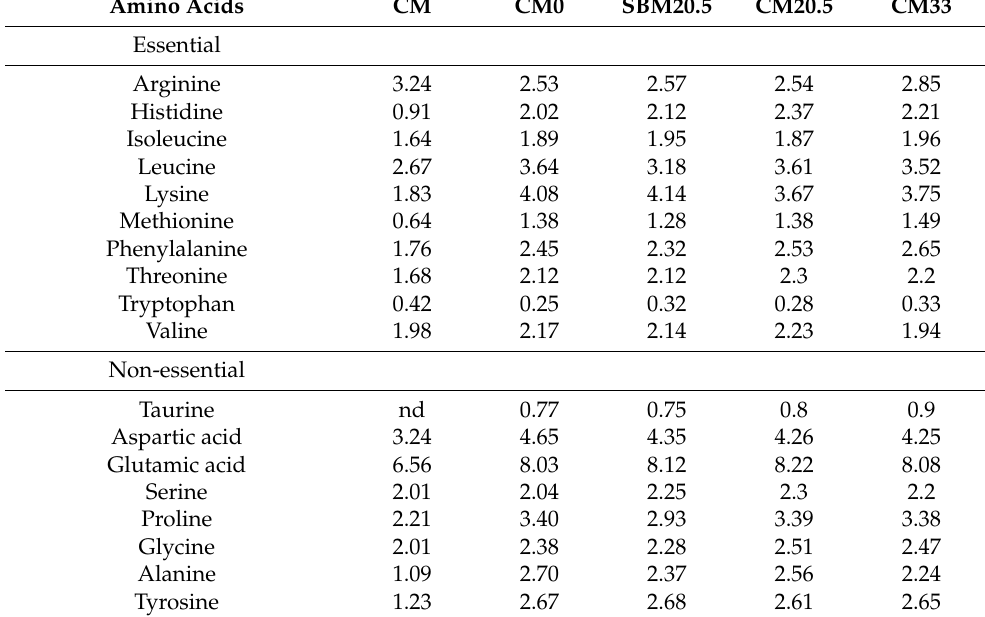
Where nd = not detected. Values are means of triplicate